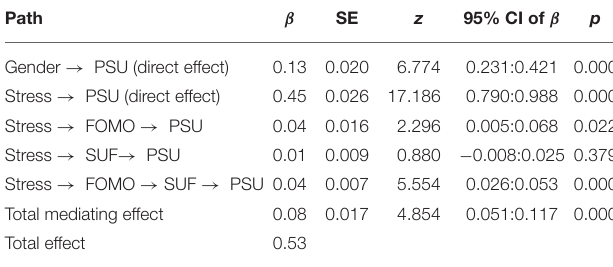
TABLE 3 | Mediating effect